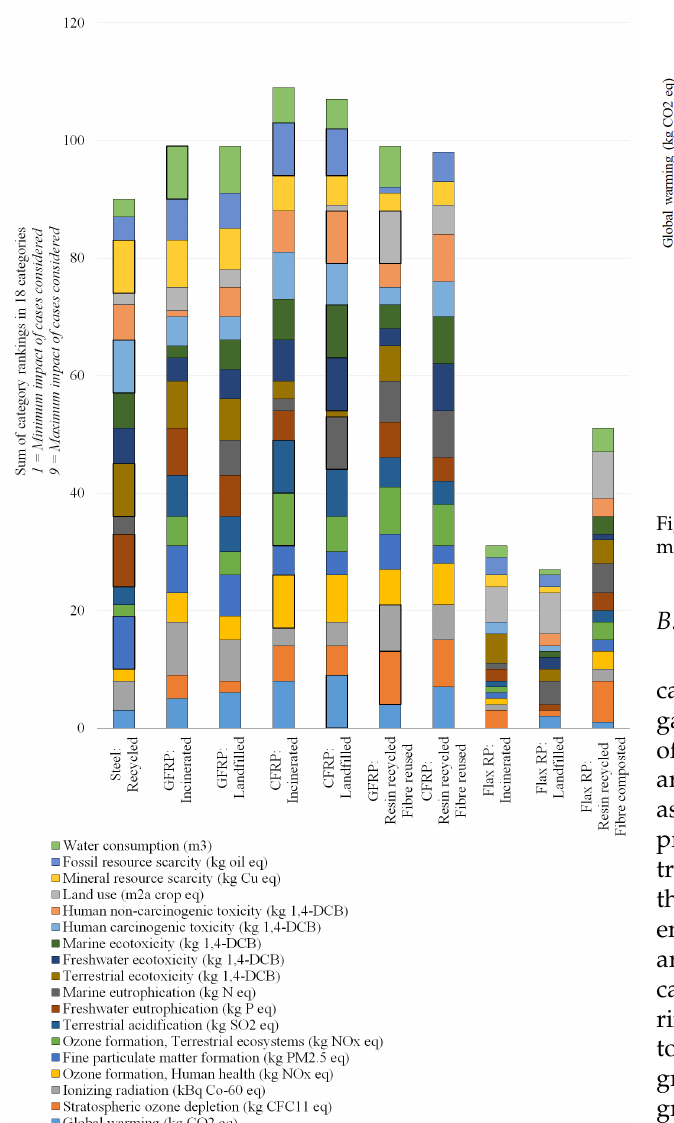
Fig. 4. Overall results of LCA study for ten blade material and treatment cases, shown in terms of ranked position in each impact category. The worst performer in each impact category is highlighted with a bold outline.